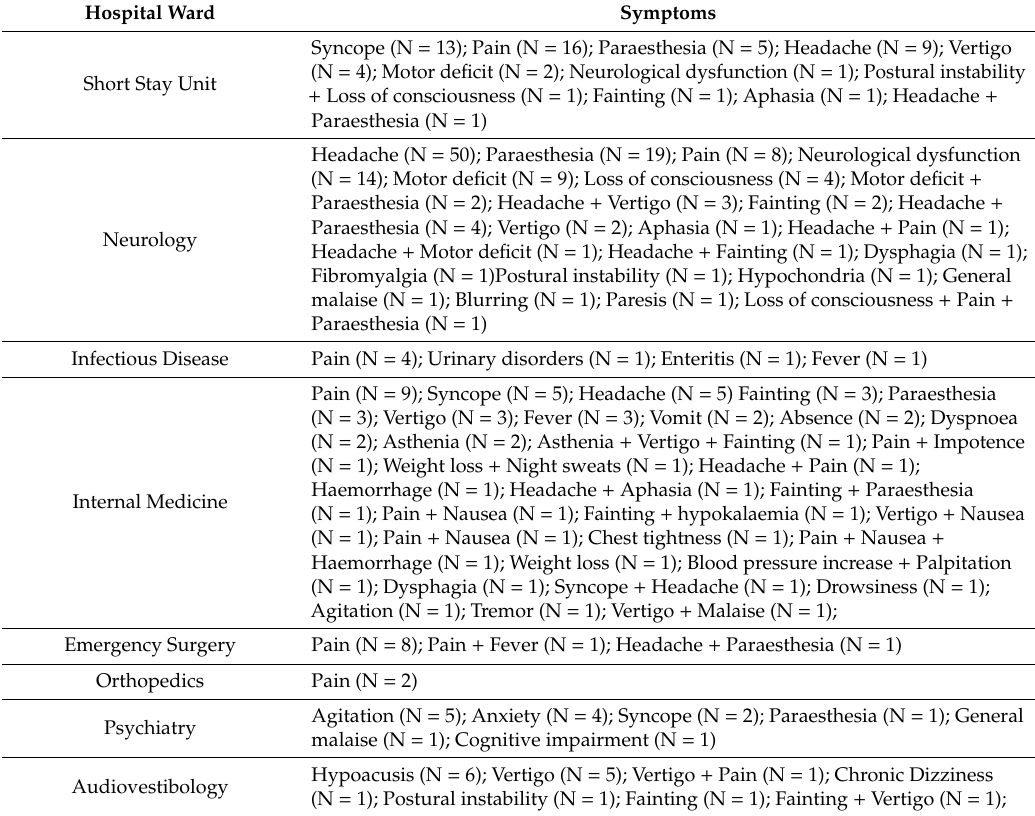
Table 4. Symptoms per